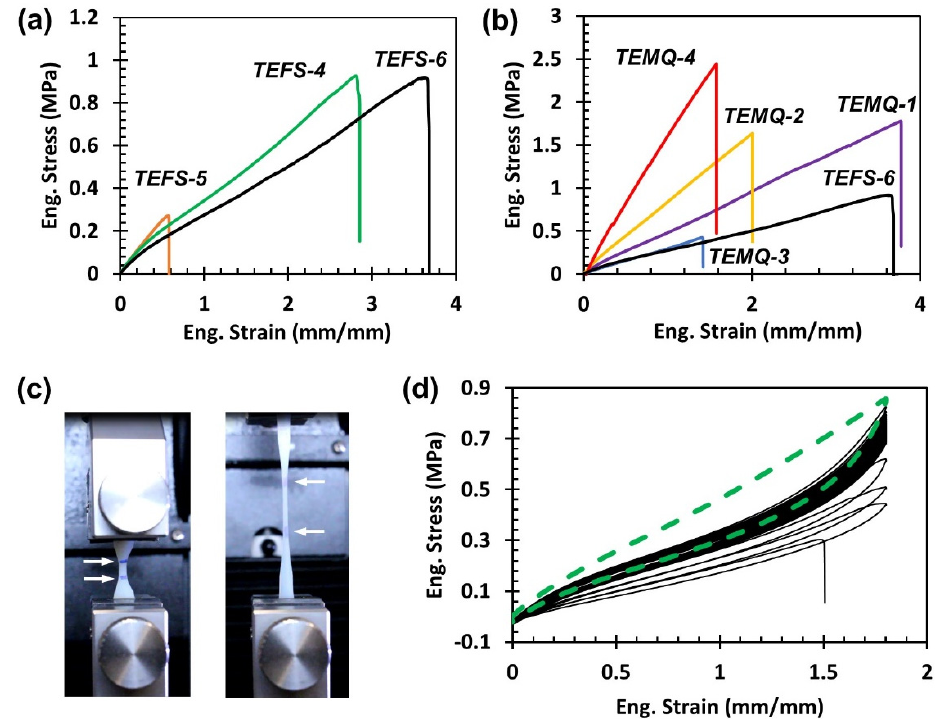
Figure 2. Mechanical properties of 3D printed tensile specimens reinforced with fumed silica (TEFS) and/or MQ resin (TEMQ). ( a ) Representative tensile tests comparing formulations with varying VTS monomers. All samples were reinforced with 33 phr fumed silica. ( b ) Representative tensile tests for fumed silica and MQ resin reinforced silicone. ( c ) Picture of a TEMS-4 specimen under tension at a strain of 1.75 mm/mm. White arrows indicate the location of blue fiducial marks used to measure engineering strain. ( d ) Cyclic tensile testing of TEFS-4. Green dotted trace corresponds to the first tensile cycle, black lines correspond to the subsequent 40 cycles, ultimately resulting in failure. Table 2. Summary of mechanical properties determined by tensile elongation, durometry, and rhe- ology. a G’ is the shear modulus of the uncured resin determined by rheology. b σ max engineering stress is the ultimate tensile strength determined by ASTM D638 testing. c ε max (mm/mm) engineer- ing strain is the elongation at break. d Ε is the Young’s modulus determined at 0.2% engineering